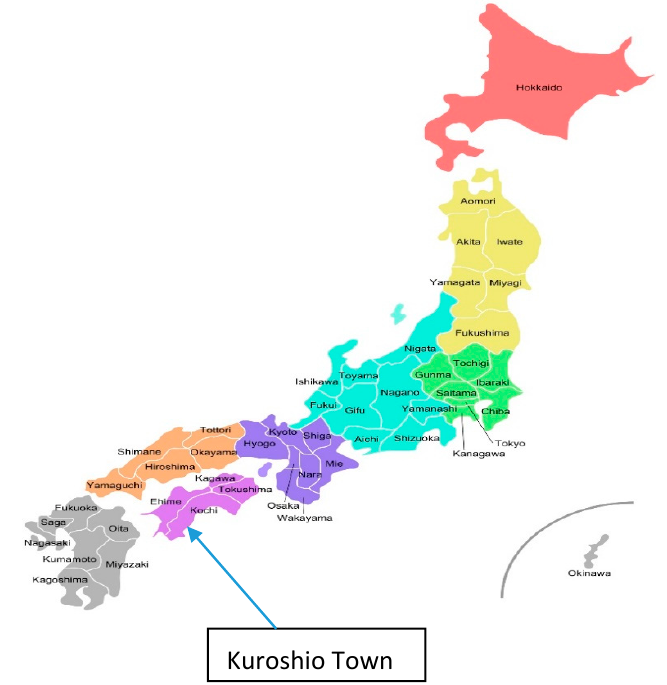
Figure 1. Location of Kuroshio Town.